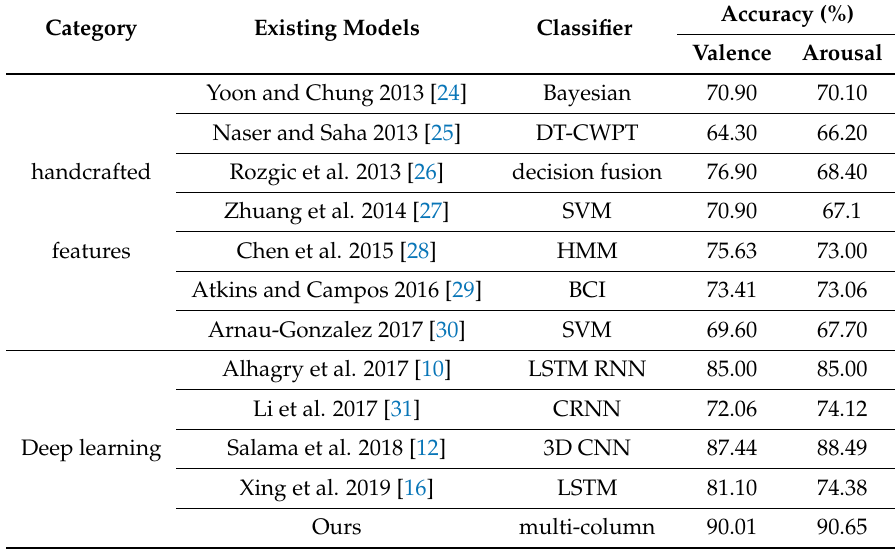
Table 4. The comparison to existing models. All of these models employ DEAP